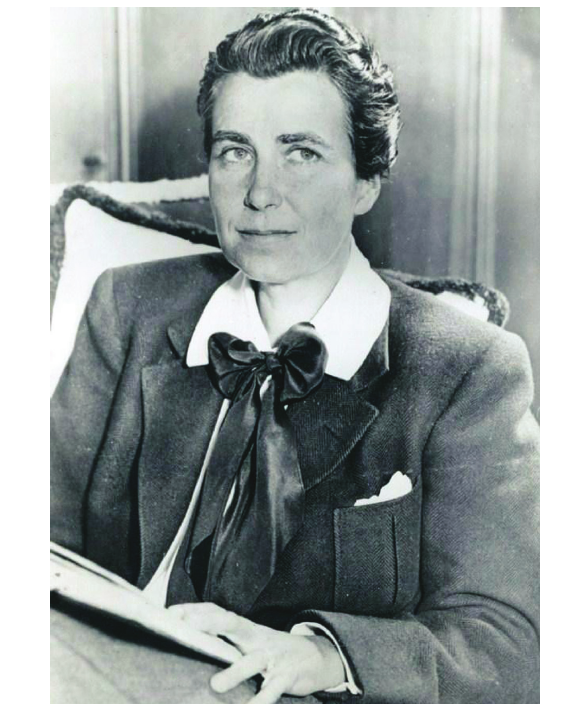
Figure 1. Dorothy Arzner (1897–1979) was a top Hollywood director during the 1930s (Source: Wikimedia